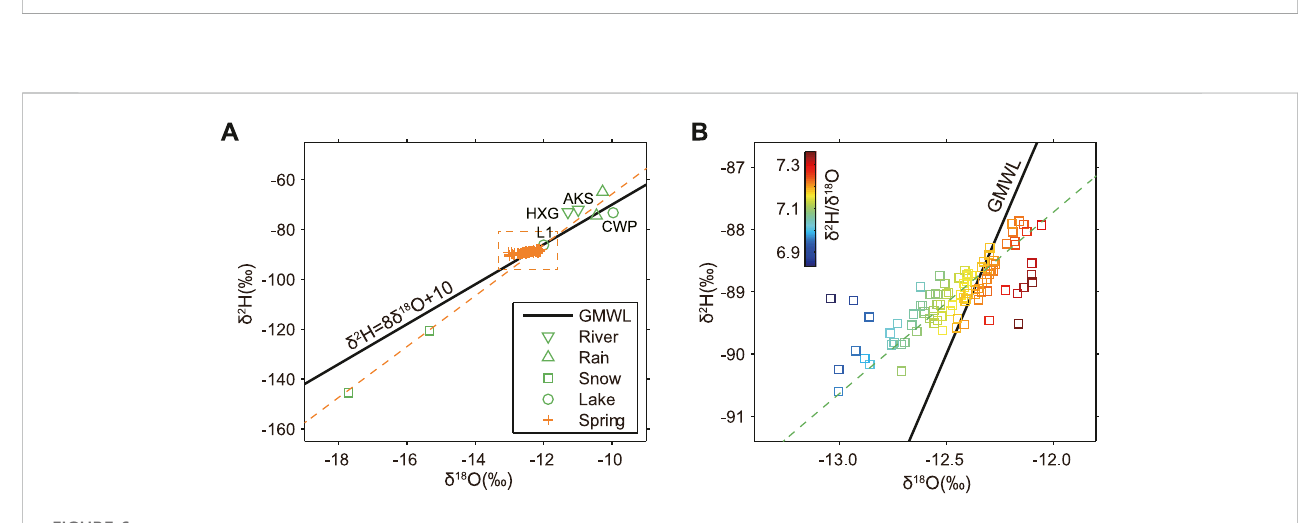
FIGURE 6 The relationship between δ 18 Oand δ 2 Hfor thesamples from differentwater bodies (A) and theenlarged δ 18 Oand δ 2 Htime variation intheX10 spring (B)